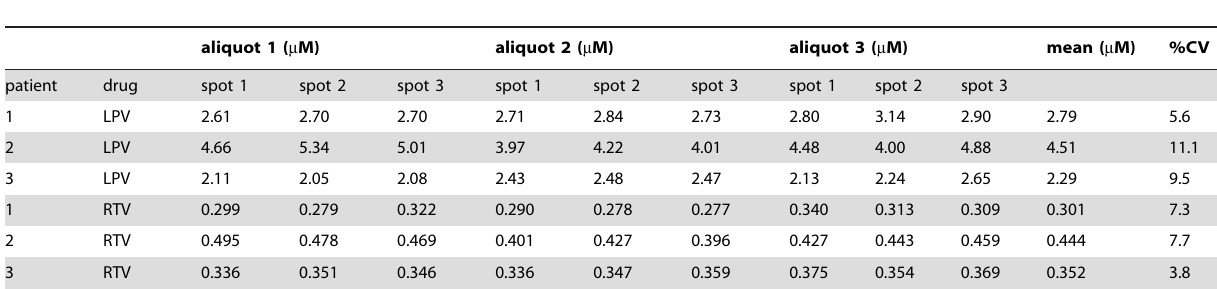
Table 2. Repeat analysis of PBMC aliquots obtained from HIV-1 infected children.